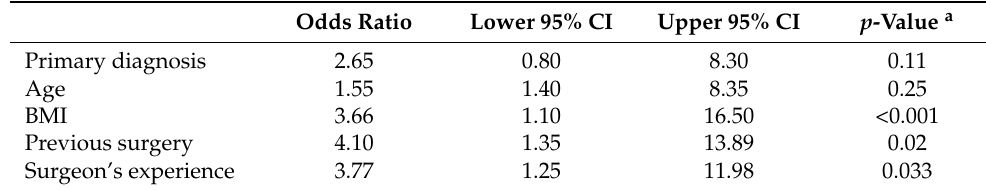
Table 5. Predictors of major (grade III) complications following MI hysterectomy: multivariable analysis.